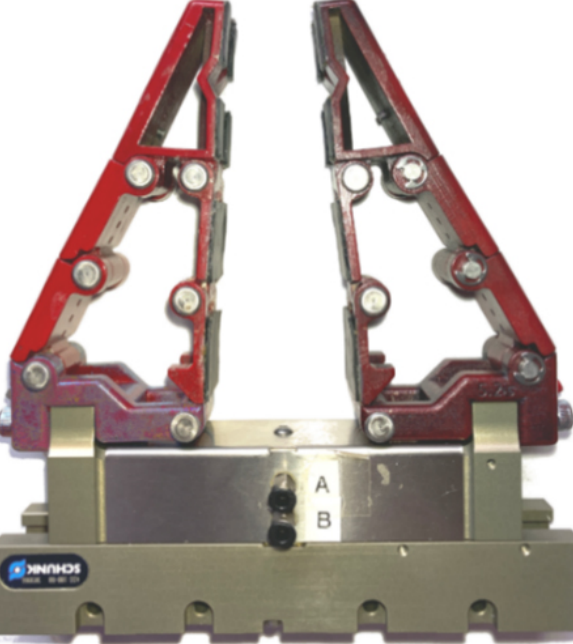
Figure 1. Fin Ray Effect fingers grasping a fruit. Grippers, RightHand Robotics RightPick, Soft Robotics Inc.